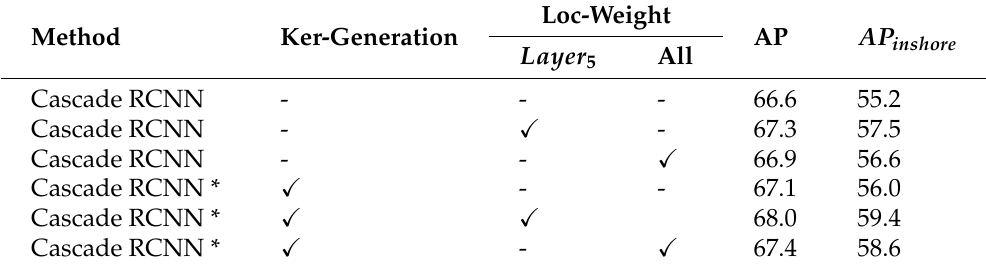
Table 7. Effects of local weight generation module.